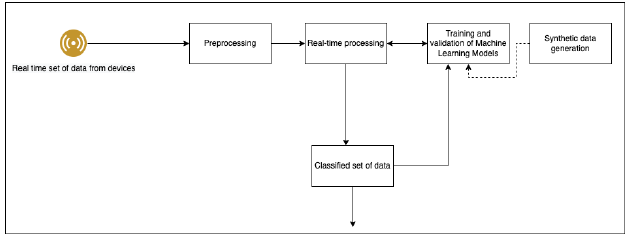
Figure 1. Systems involved in the architecture of the proposed model for anomaly classification (pre-processing, real-time processing, training and validation and synthetic data